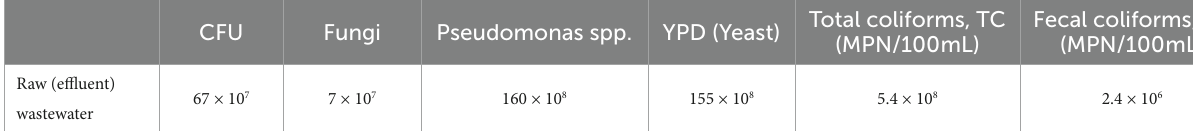
TABLE 1 Microbiological characterization of the effluent quality. CFU Fungi Pseudomonas